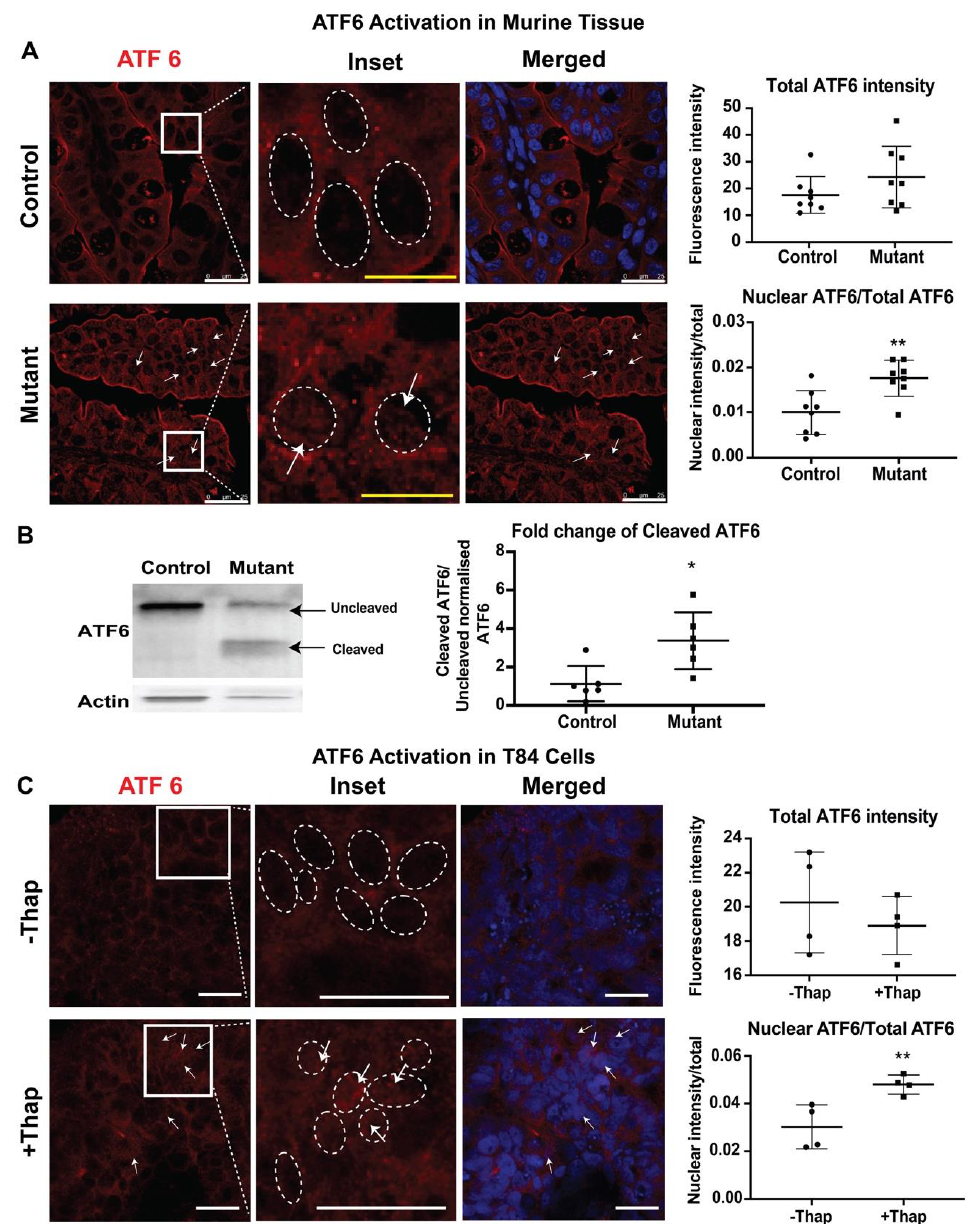
Figure 4. Activating transcription factor (ATF6) mediated pathway: Representative confocal images showing expression of ATF6 (red) and Draq5 staining for the nuclear DNA (blue) in ( A ) small intestinal sections of control and mutant mice. The middle panels show enlarged images of the cells within the sections marked by the white boxes. The dashed oval represents the nuclear border and arrows denote increased levels of the nuclear-localized ATF6. Upper graphs demonstrate total ATF6 fluorescence intensity. Lower graphs demonstrate nuclear ATF6 ( n = 8) ( B ) Western blot image and quantification of uncleaved ATF6 (MW ~90 KDa) and cleaved ATF6 (MW ~50 KDa) with respect to actin in control / mutant murine intestinal tissue lysate ( n = 6). Black arrow denotes the respective uncleaved and cleaved ATF6 fragment in the blot. ( C ) Representative confocal images showing expression of ATF6 (red) and Draq5 staining for the nuclear DNA (blue) in T84 cells with ( + ) or without ( − ) thapsigargin (Thap) treatment ( n = 4). *, p < 0.05, **, p < 0.01 by student t -test in all the images. Scalebar represents 25 µ